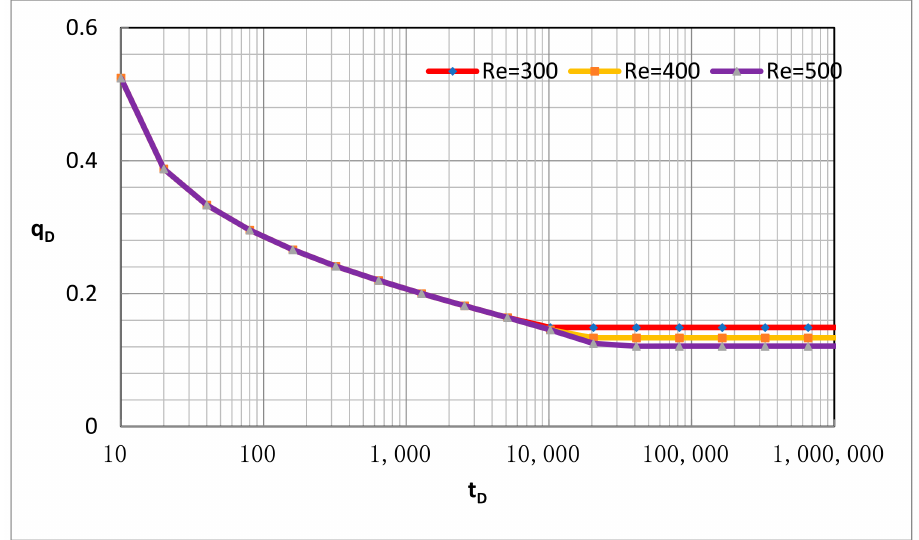
Figure 12. Production decline curve of stable boundary low-permeability reservoir with different outer boundary